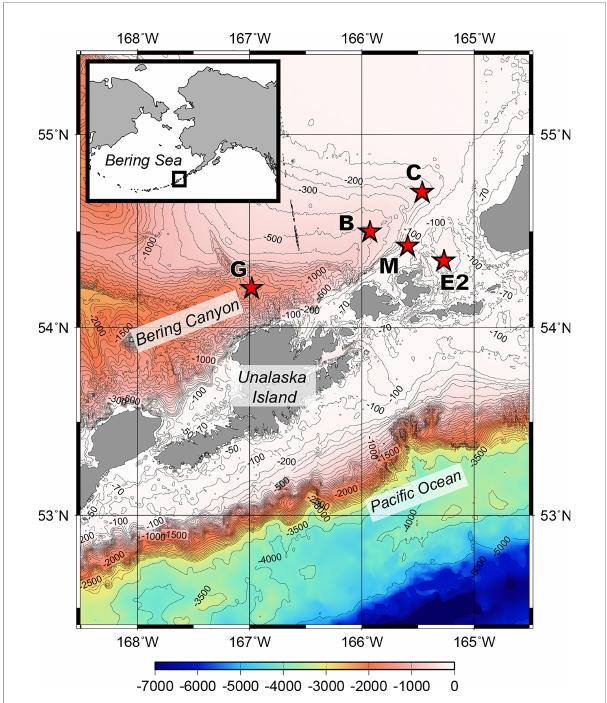
FIGURE 1 Bathymetric map of the southeastern Bering Sea showing